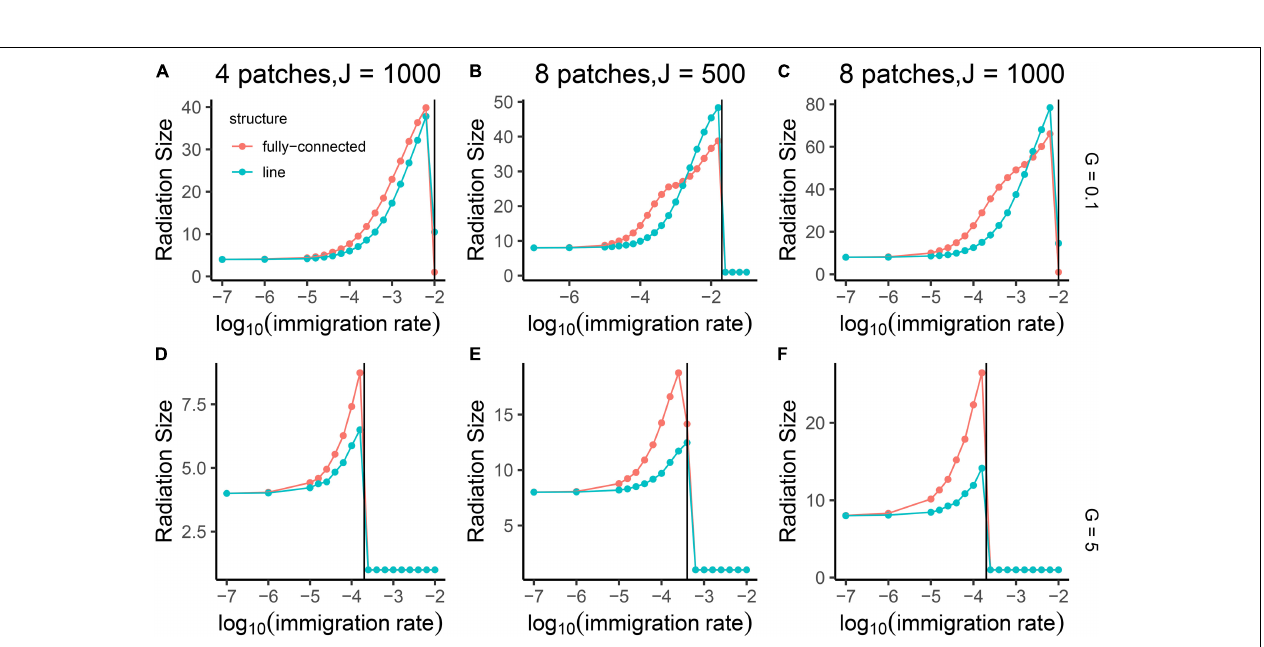
FIGURE 6 | Mean radiation size of the single lineage in the community network, shown as a function of internal dispersal rate (m) on log 10 scale. The three columns of panels correspond to three different sizes of community network: 4 patches each with 1000 individuals (A,D) , 8 patches each with 500 individuals (B,E) , and 8 patches each with 1000 individuals (C,F) . The gene flow effect (G) was set to 5 and 0.1 shown as two rows of panels. Blue lines represent results from a line-structured network of local patches, and red lines represent results from a fully-connected structure. The vertical black lines give the predicted value of the critical point m crit for each panel based on the formula m crit = 1 G × J that was described in the Material and Methods section.